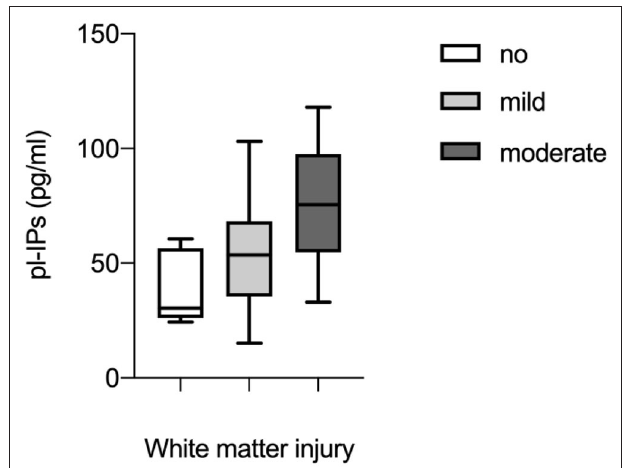
FIGURE 1 | Correlation between plasma levels of isoprostanes (pl-IPs) between 24 and 48h after birth and WMI evaluated according to the scoring system by Woodward et al. (6). Multivariable regression analysis ( p = 0.037).